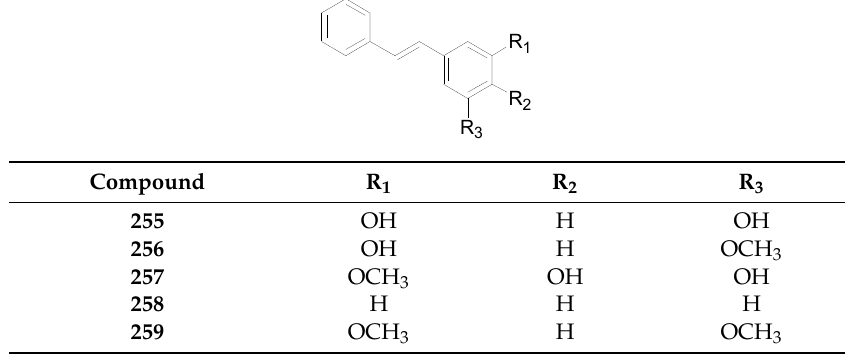
Table 16. Structures of compounds 255 – 259 .